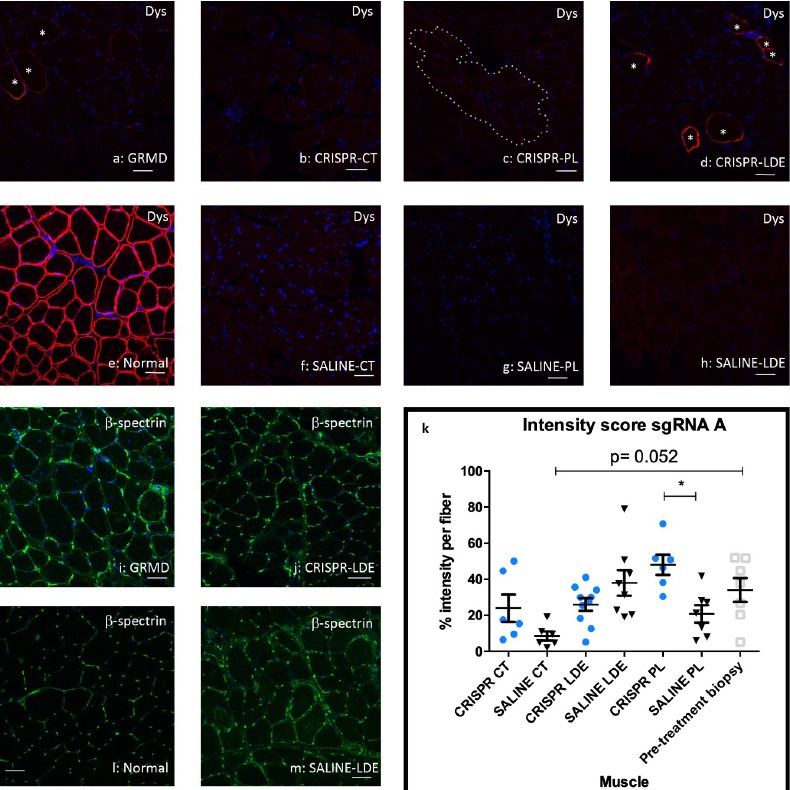
Fig 6. Dystrophin expression was minimally restored in HDR-CRISPR-Tx muscle from sgRNA A. Dystrophin co- stained with C and N-terminus antibodies with Alexa 647 (red), β -spectrin membrane control (green) and DAPI denotes the nuclei (blue). Asterisks denote cells with a value of 2 in intensity score for dystrophin signal in the GRMD non-Tx and Tx samples. Dotted line denotes cells with a value of 1 in intensity score. Scale bar = 50 μ m. (a) Pre- treatment biopsy sample for Miercoles. (b) HDR-CRISPR injected cranial tibial (CT) Miercoles. (c) HDR-CRISPR injected peroneus longus (PL) Miercoles. (d) HDR-CRISPR injected long digital extensor (LDE) Miercoles. (e) Normal dog muscle. (f) SALINE injected CT Miercoles. (g) SALINE injected PL Miercoles. (h) SALINE injected LDE Miercoles. (i) Pre-treatment biopsy sample for Miercoles. (j) HDR-CRISPR injected LDE Miercoles. (k) Dystrophin intensity quantification for Miercoles and Friendly via One-way ANOVA multiple comparisons test, blue circle indicates CRISPR-Tx limb, black triangle indicates SALINE-Tx limb, gray square indicates pre-treatment biopsied sample; � p < 0.05. (l) Normal dog muscle (m) SALINE injected LDE Miercoles. Dys = dystrophin; p = p.